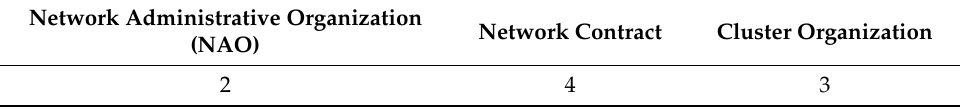
Table 4. Governance